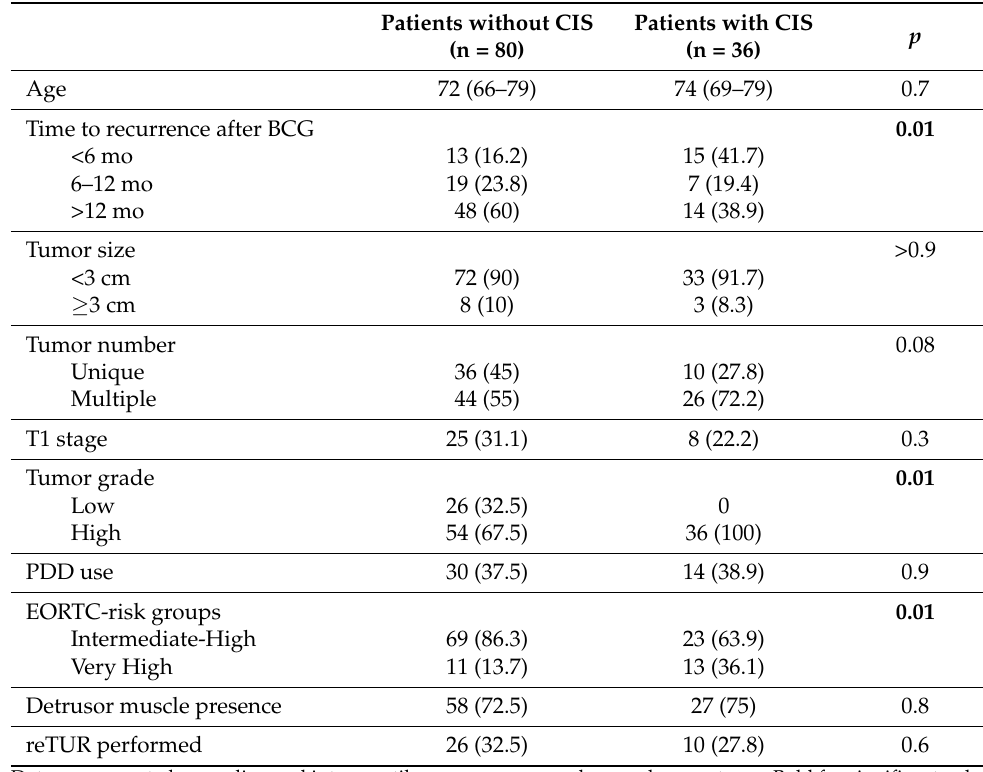
Table 1. Baseline